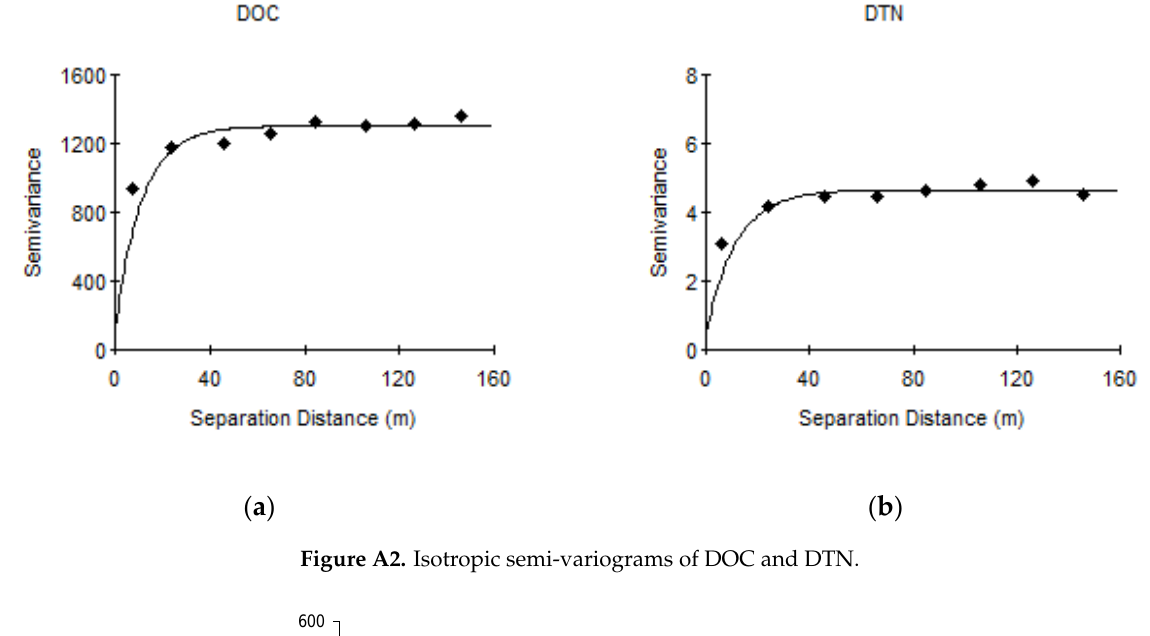
Figure A1. Relationship between the CV of pH, soil temperature, and moisture with increasing sampling areas. Error bars represent the standard error of the mean.